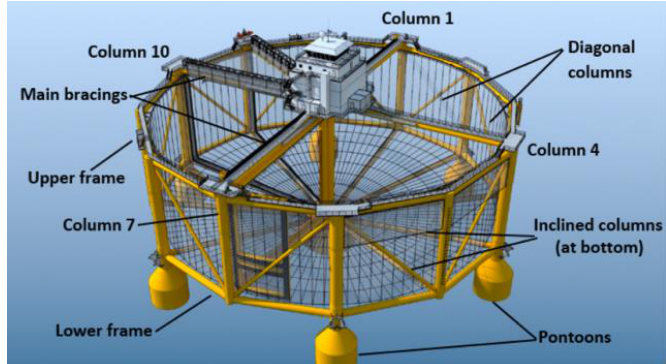
Figure 1. Illustration of Ocean Farm 1 [1]. Reprinted/adapted with permission from Ref. [1]. 2021, Jin, J.; Su, B.; Dou, R.; Luan, C.; Li, L.; Nygaard, I.; Fonseca, N.; Gao, Z.